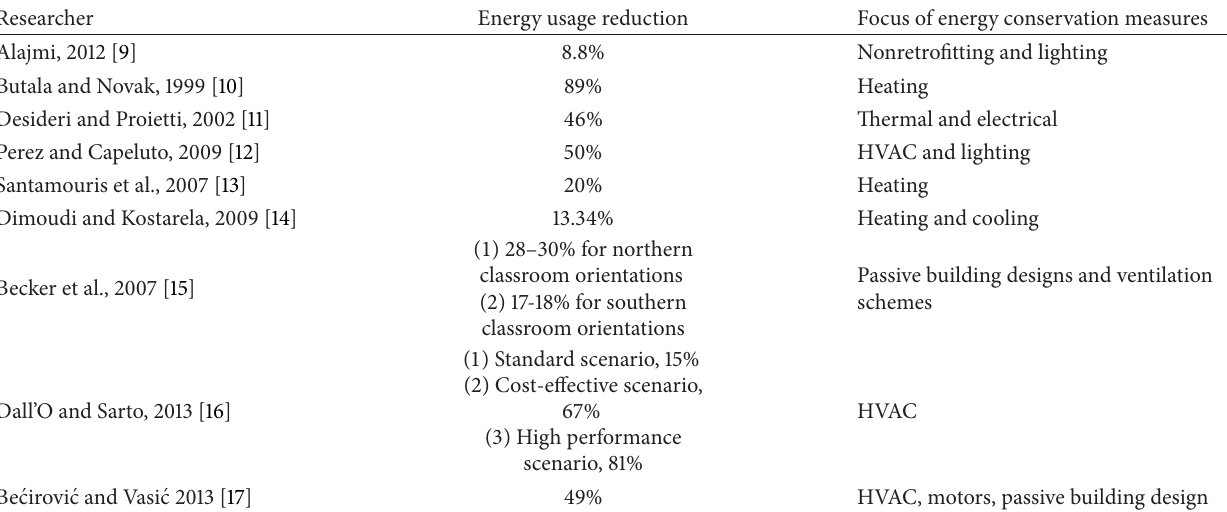
Table 14: Energy usage reduction results for various researches carried out on schools.